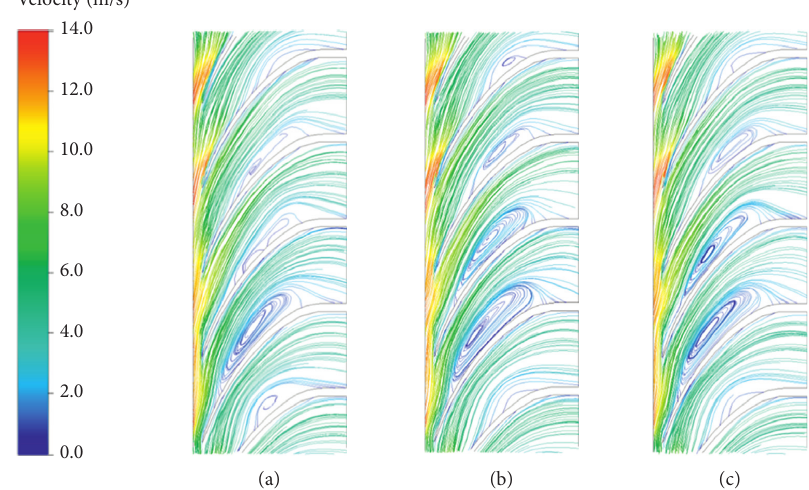
Figure 17: Streamline diagram of the guide vane: (a) 5mm, (b) 10 mm, and (c) 15mm.